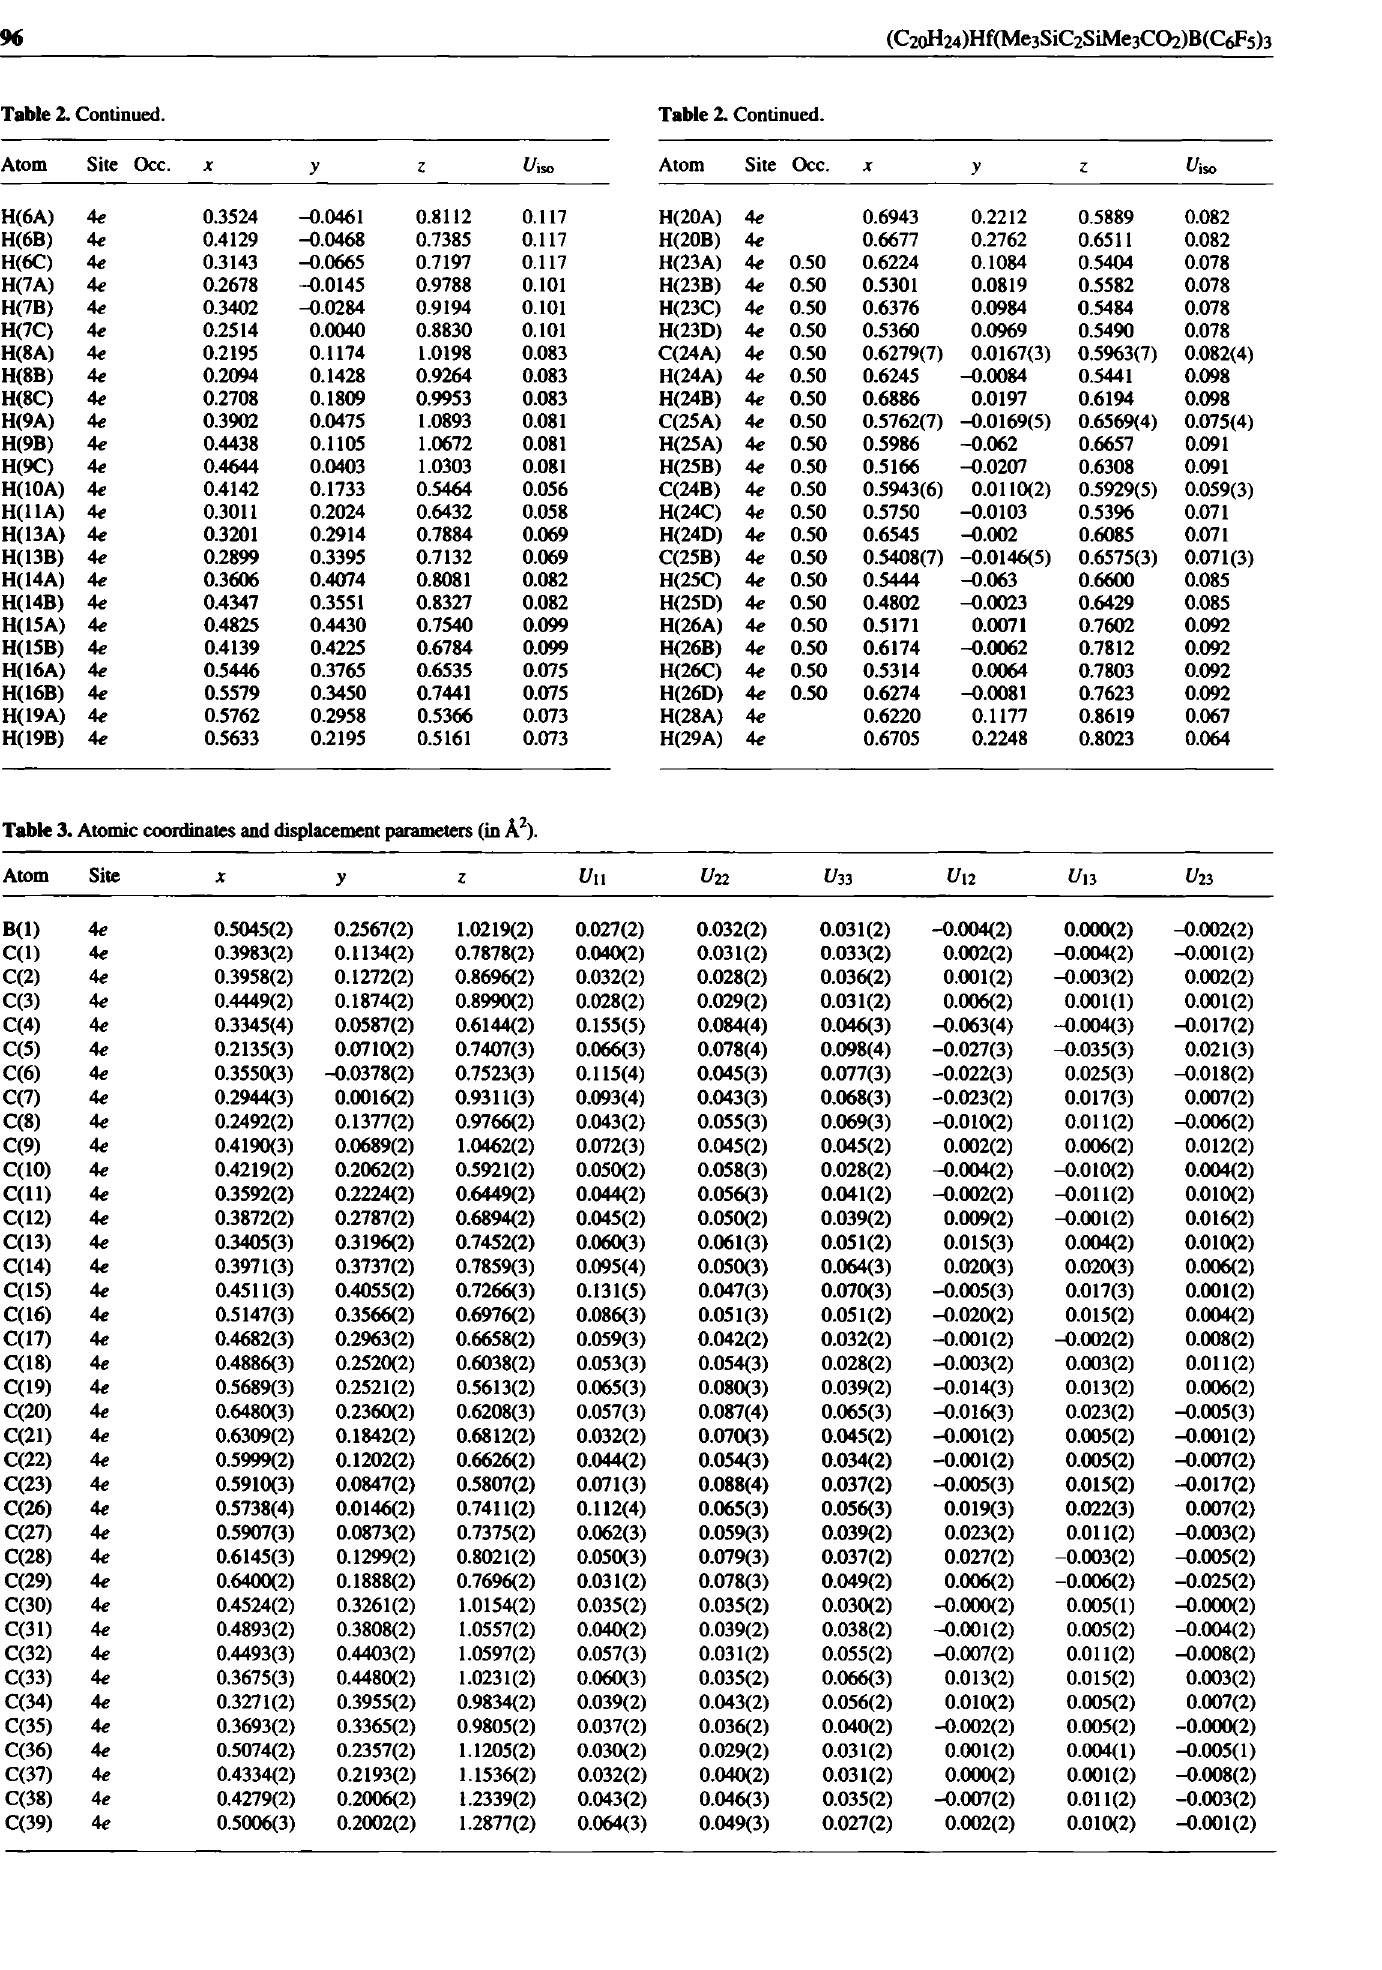
Table 3. Atomic coordinates and displacement parameters (in Â 2